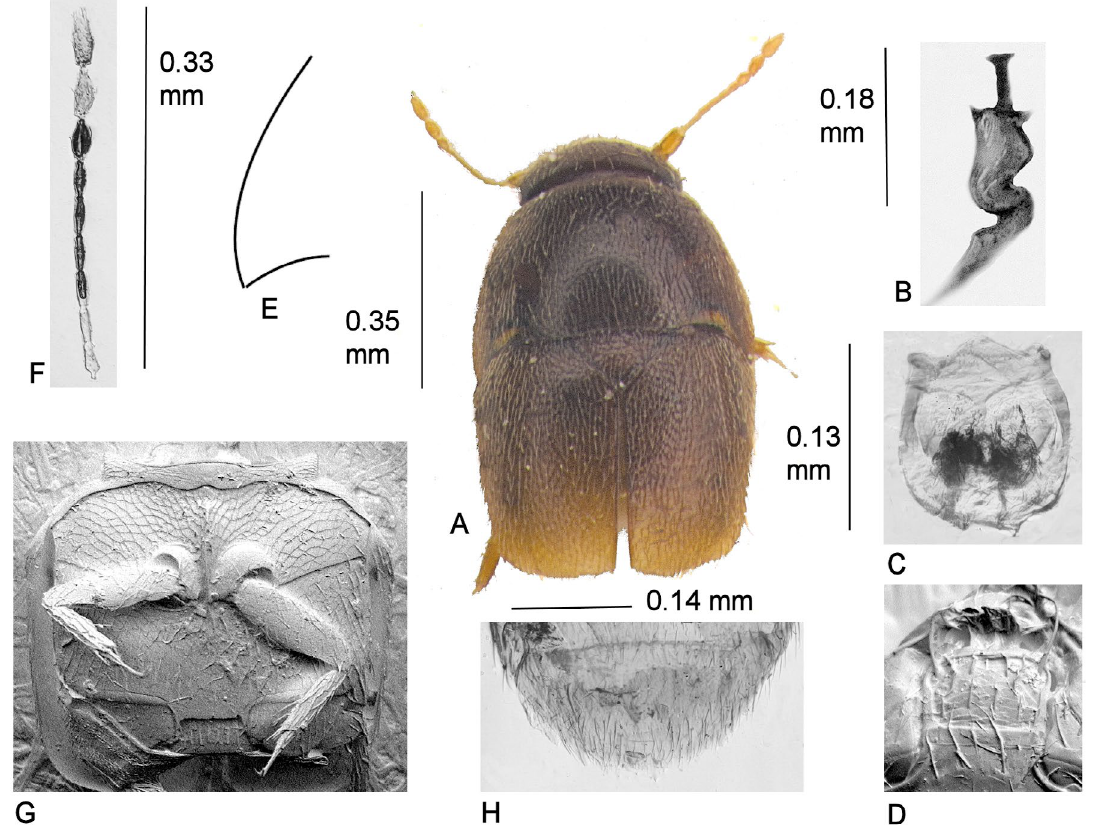
Fig. 22. Acrotrichis plaga sp. nov. A . Habitus. B . Spermatheca. C . Aedeagus. D . Mentum and submentum ×1580. E . Hind angle of pronotum viewed at 45°. F . Antennomeres III–XI. G . Meso- and metaventra ×272. H .